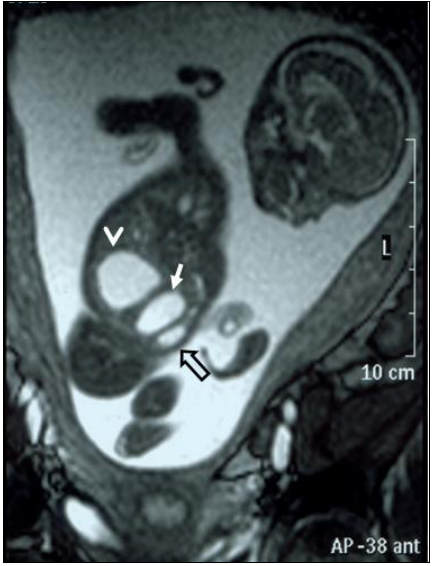
Figure 5: Fetal MRI coronal